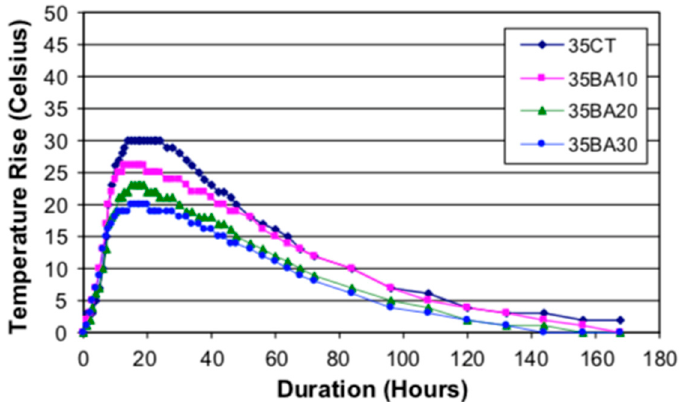
Figure 11. Semi-adiabatic temperature rise in concrete containing sugarcane bagasse ash (a number at the end indicates the percentage of sugarcane bagasse ash) [106].